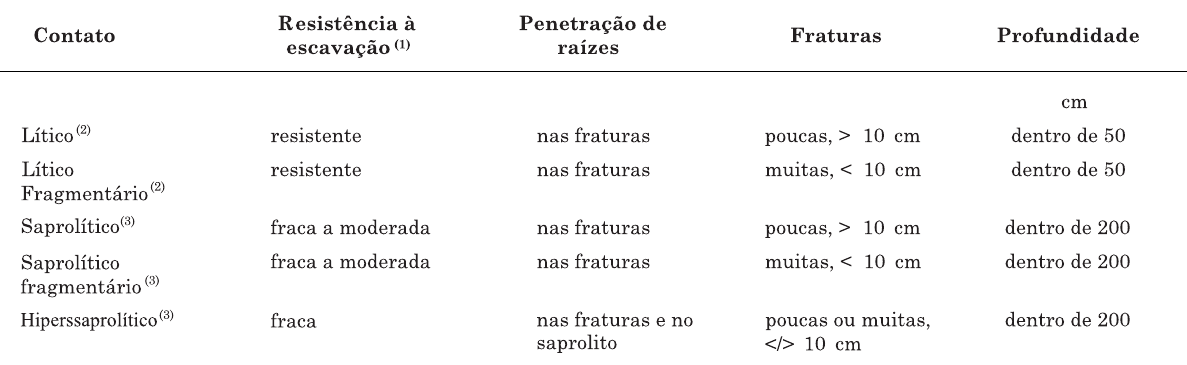
Figura 2. Diagrama de fraturas das camadas saprolíticas dos Neossolos analisados. Quadro 3. Atributos diagnósticos relacionados aos contatos entre solo, saprolito e rocha, para as classes dos Neossolos Litólicos e Regolíticos derivados de rochas vulcânicas no Rio Grande do Sul (Embrapa, 2006 e sugestões dos